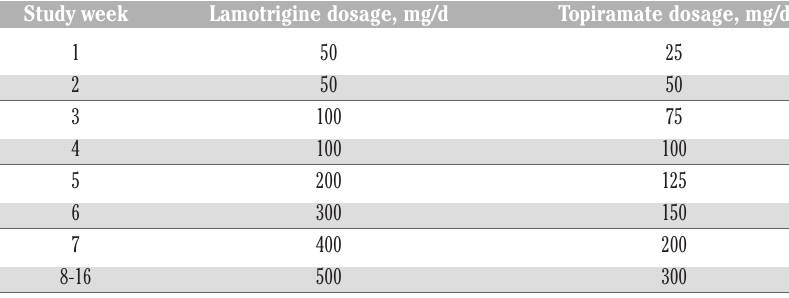
Table 1. Dosage escalation schedules for lamotrigine and topiramate.